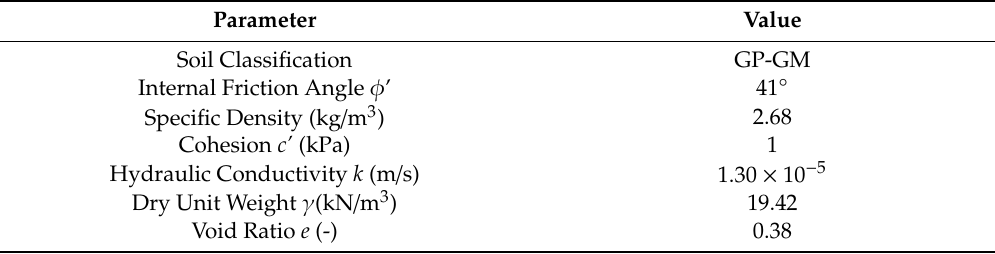
Figure 6. Model slope-bedrock geometry for the numerical modelling with bedrock step and toe (type c) with units in m. Table 3. Soil properties for the numerical simulations with SEEP / W and SLOPE / W.